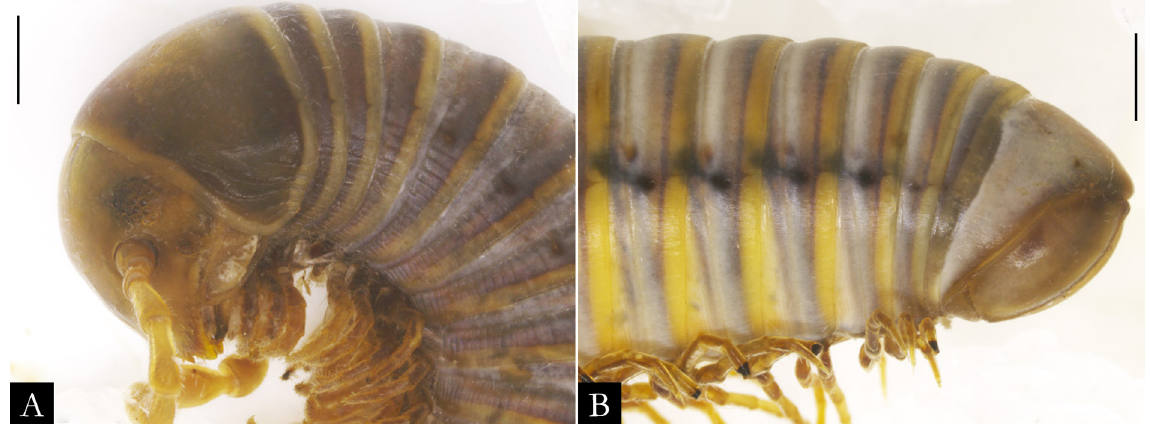
Fig. 103. Pseudonannolene parvula Silvestri, 1902, ♂ (IBSP 7630), in lateral view. A . Anterior region. B . Posterior region. Scale bars = 0.5